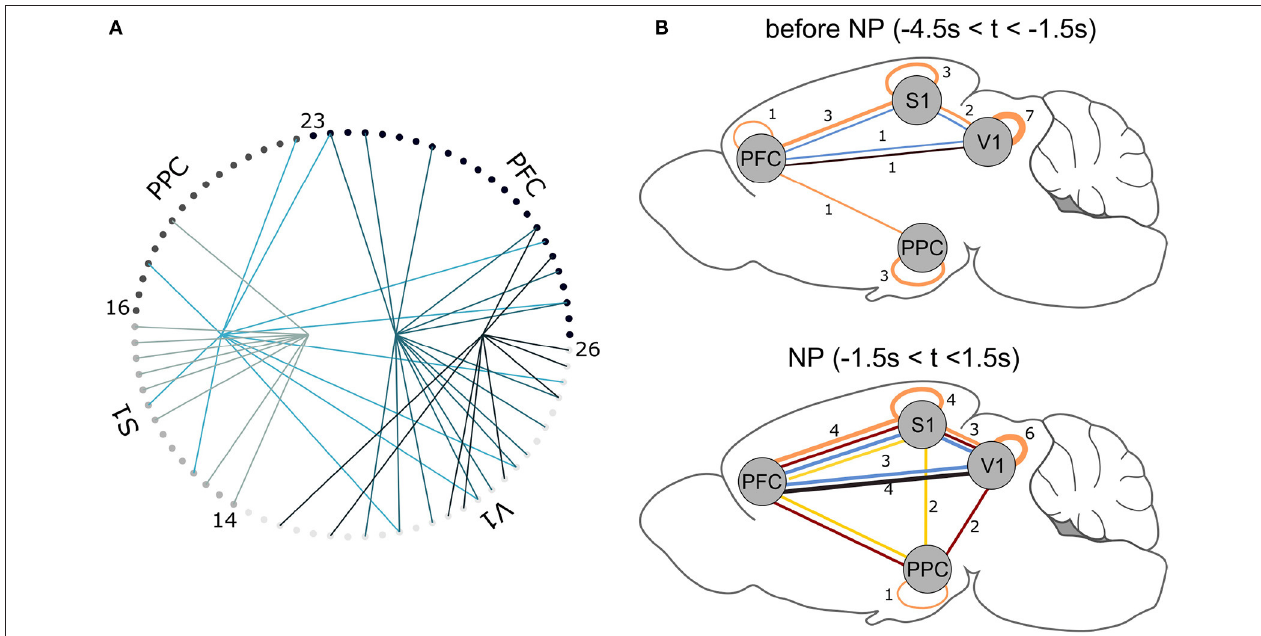
FIGURE 6 | (A) NAs found for Rat 1. For each trial, 3 s data segments were selected centered on NP. Each small circle corresponds to one recorded neuron (see Table 2 ); lines of equal color connect neurons that belong to the same NA. (B) NA summary for all animals. Lines connect cortical areas where at least 10% of cells were engaged in the same (color-coded) NA. The thicker the connections, the greater the number of animals presenting NAs between the indicated cortical regions. For example, in the NP time window, 3 animals presented functional interactions within PFC, S1 and V1 (blue NA); before NP, only one animal displayed this interaction. Brain template adapted from Töle